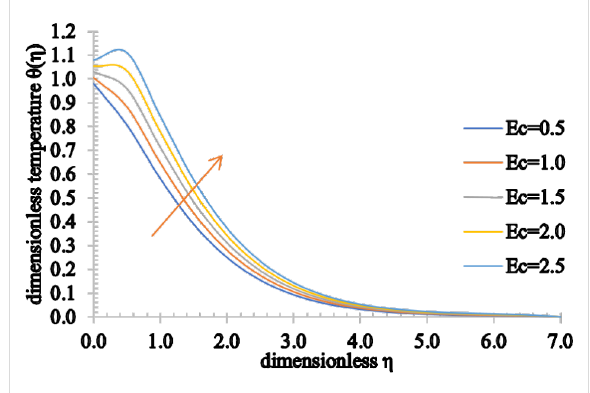
Figure 10: The concentration profile for increasing values of β .